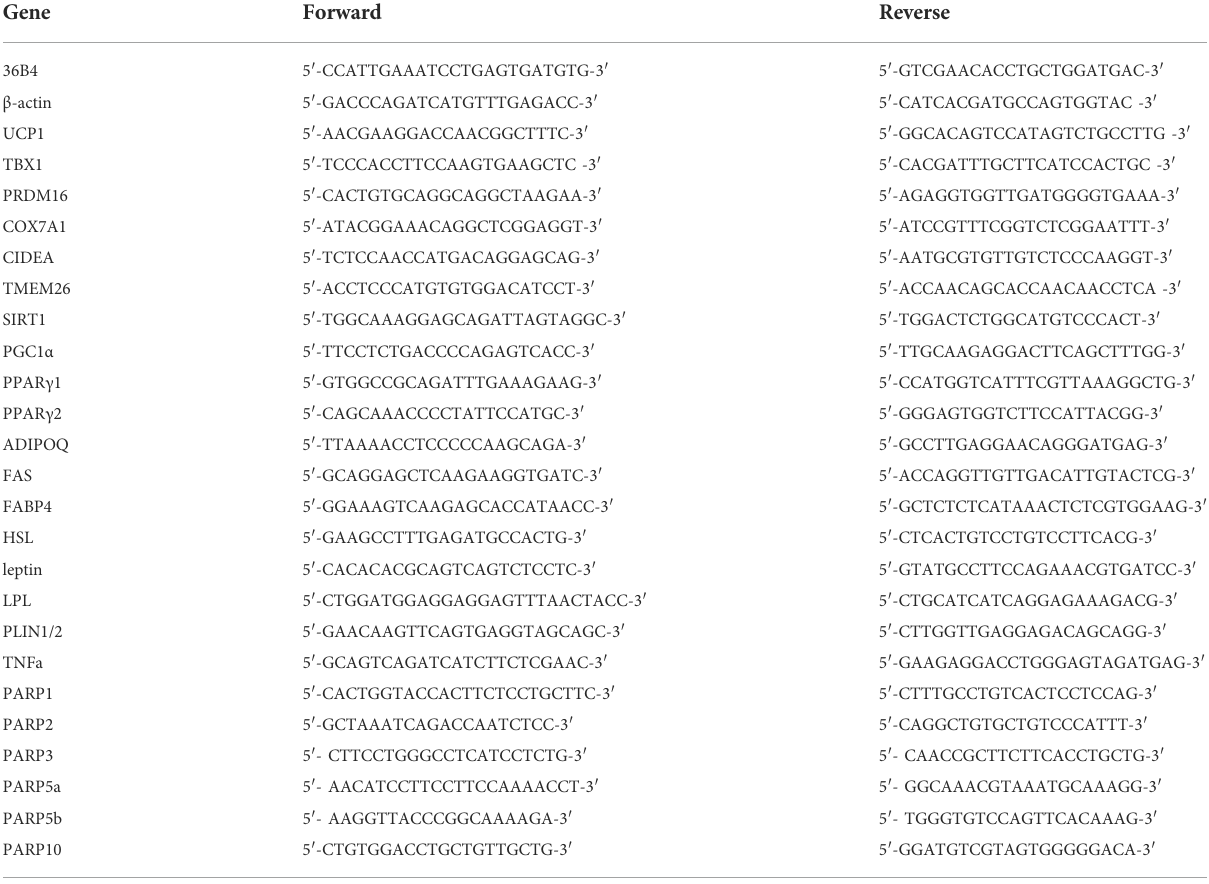
TABLE 1 Human primers used in RT-qPCR reactions.